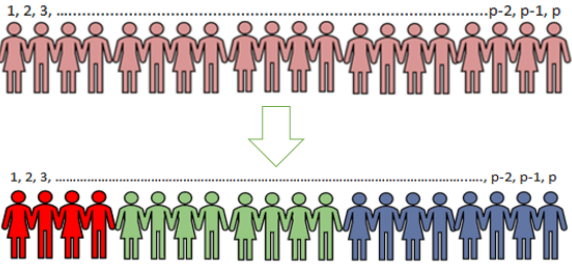
Figure 4. Visualization of the characterization obtained through the unsupervised algorithm of agglomerative